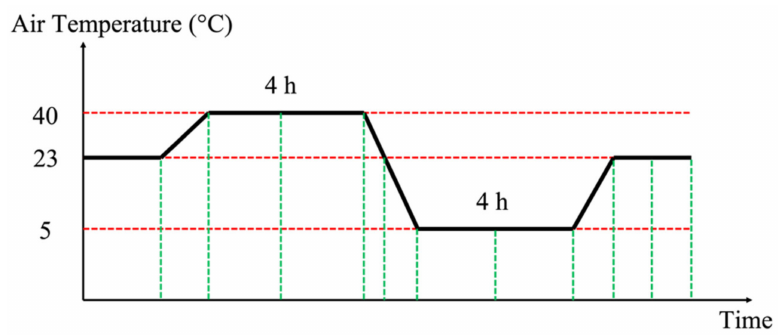
Figure 2. Accuracy vs. temperature test specified in